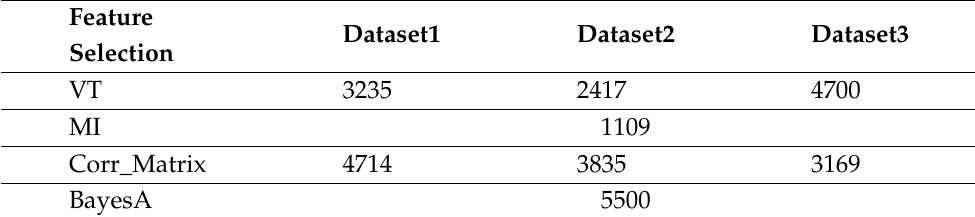
Table 1. List of selected features by each feature selection method per